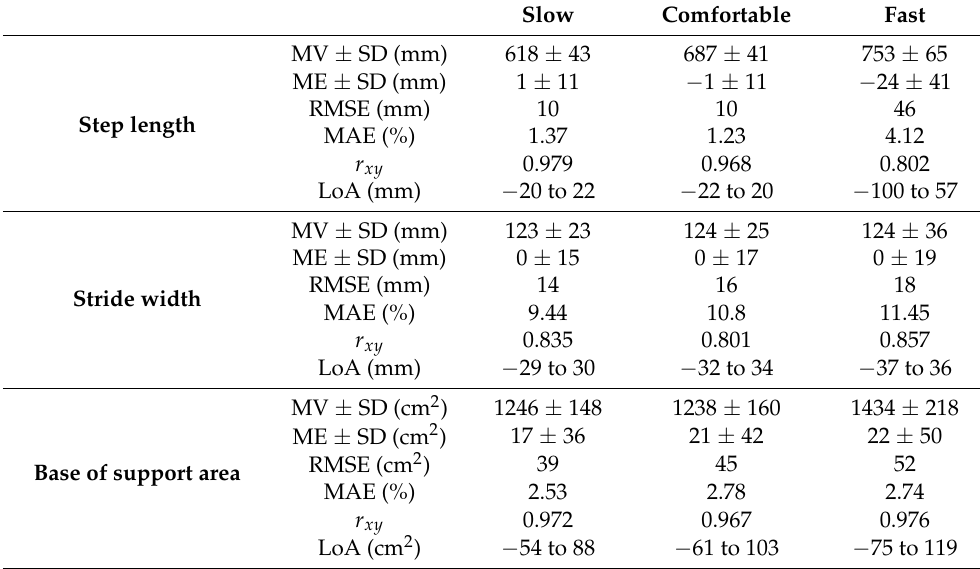
Table 2. Results of base of support parameters: mean values (MV) and differences with respect to stereophotogrammetric system. ME = mean error, RMSE = root mean squared error, MAE = mean absolute error, r xy = Pearson correlation coefficient, LoA = limits of agreement at 95%.